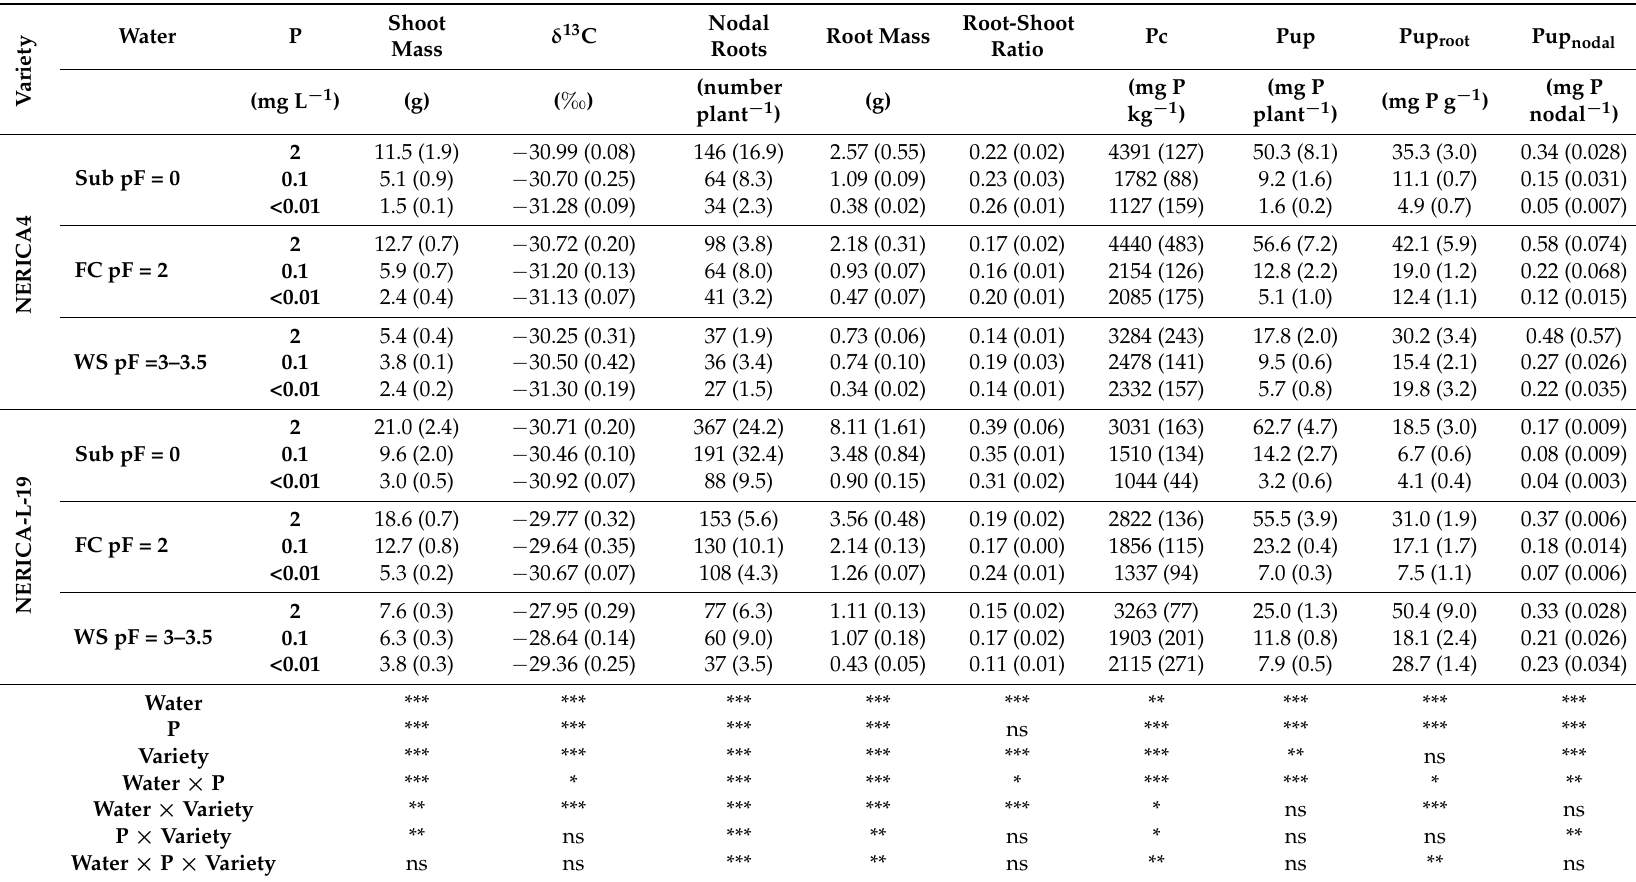
Table 3. Shoot, root, carbon isotope discrimination, and P uptake data from two varieties grown in a pot trial using lowland soil to which P was applied to achieve submergence (Sub). Data are presented as means with (standard errors). Probabilities of F-statistics for the treatment effects are presented at the bottom of the table. (Pc = Shoot P concentration; Pup = Total P uptake by the shoot; Pup root = Shoot P uptake per unit root weight; Pup nodal = Shoot P uptake per nodal